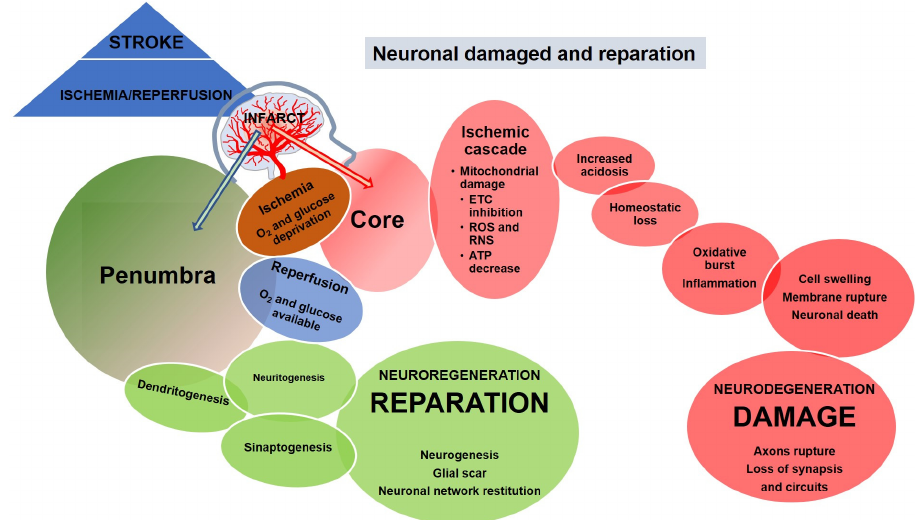
Figure 2. Ischemic stroke damage and repair mechanisms. Stroke triggers diverse mechanisms of damage and restoration during both the ischemic and reperfusion periods. The damage mechanisms mainly affect the core zone of the infarct. Conversely, repair mechanisms try to restore the damage zone and mainly occur in the penumbra of the infarct.